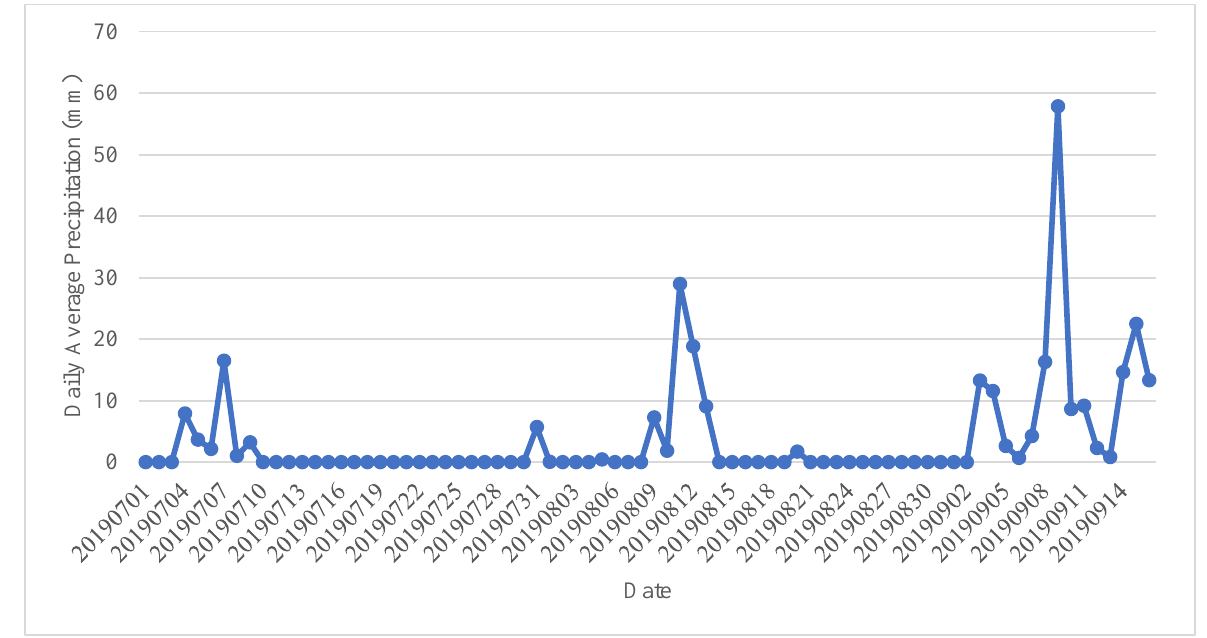
Figure A2. Daily average precipitation in the study area.